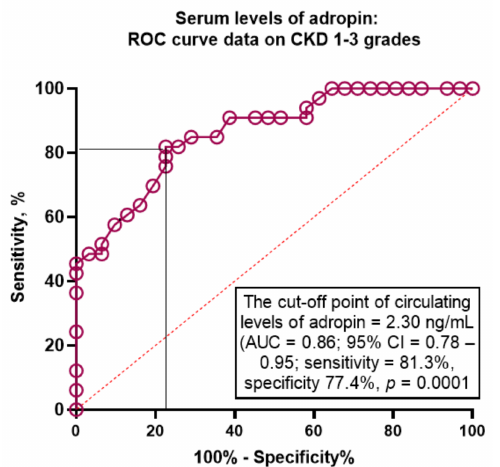
Figure 3. The predictive model based on the serum levels of adropin for CKD 1–3 grades: The results of ROC curve analysis. Abbreviations: AUC, area under the curve; CI, confidence interval; HF, heart failure; CKD, chronic kidney disease; ROC, Receive Operation Curve; T2DM, type 2 diabetes mellitus.